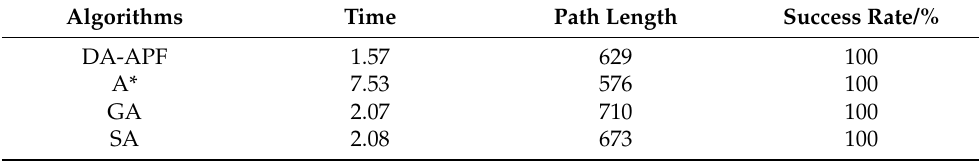
Table 1. Performance results for Environment I (mean values from 50 runs for all algorithms).